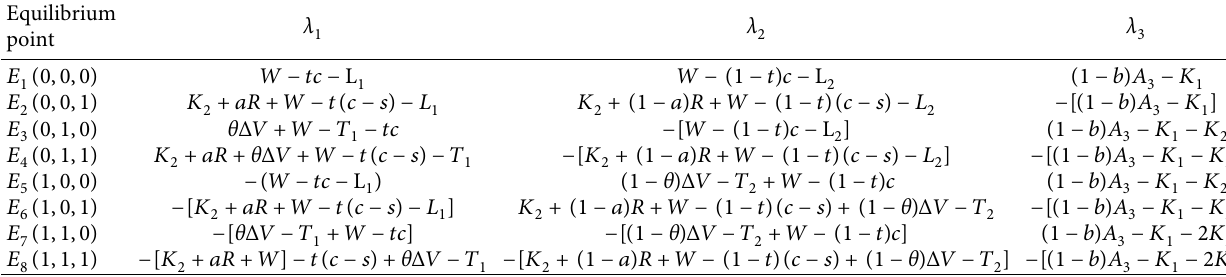
Table 5: Eigenvalues of Jacobian